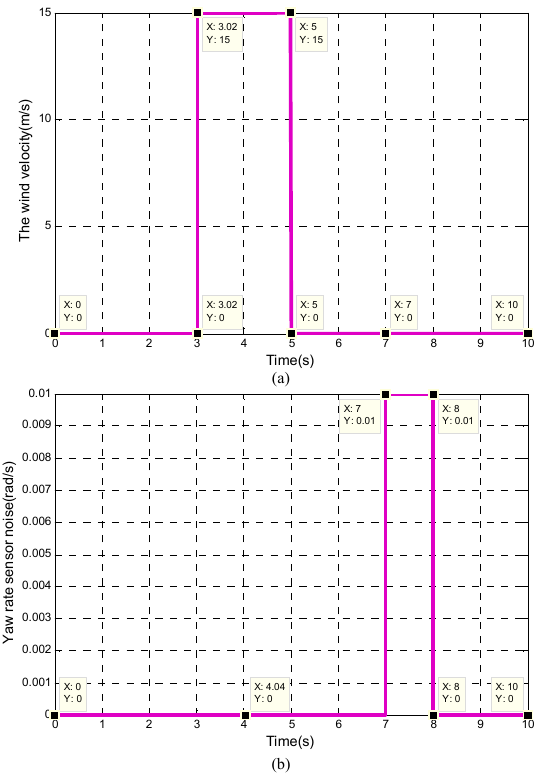
Figure 17. The disturbances signals: ( a ) side wind; ( b ) yaw rate sensor noise.